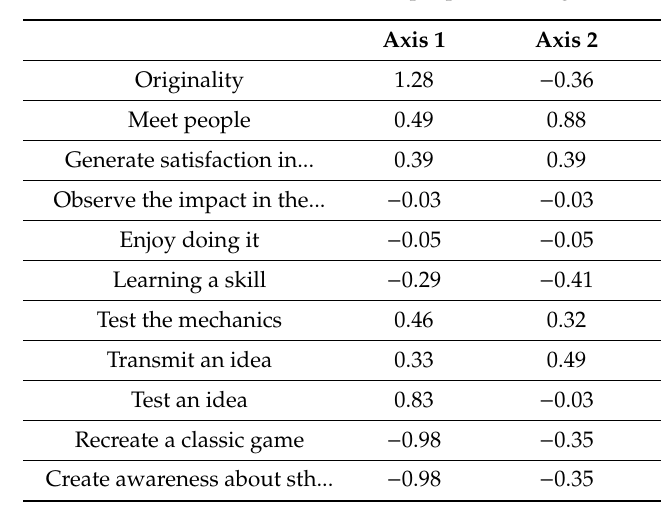
Table 6. Column of education and purpose of the game.